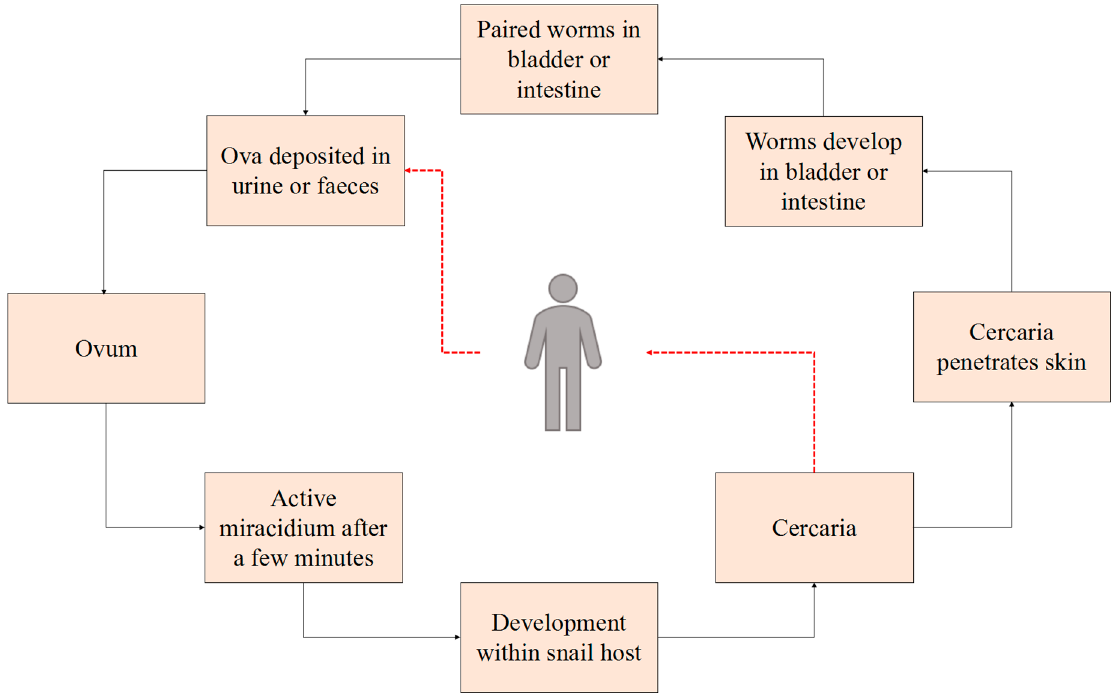
Figure 6. Disease transmission and life cycle of schistosomiasis.